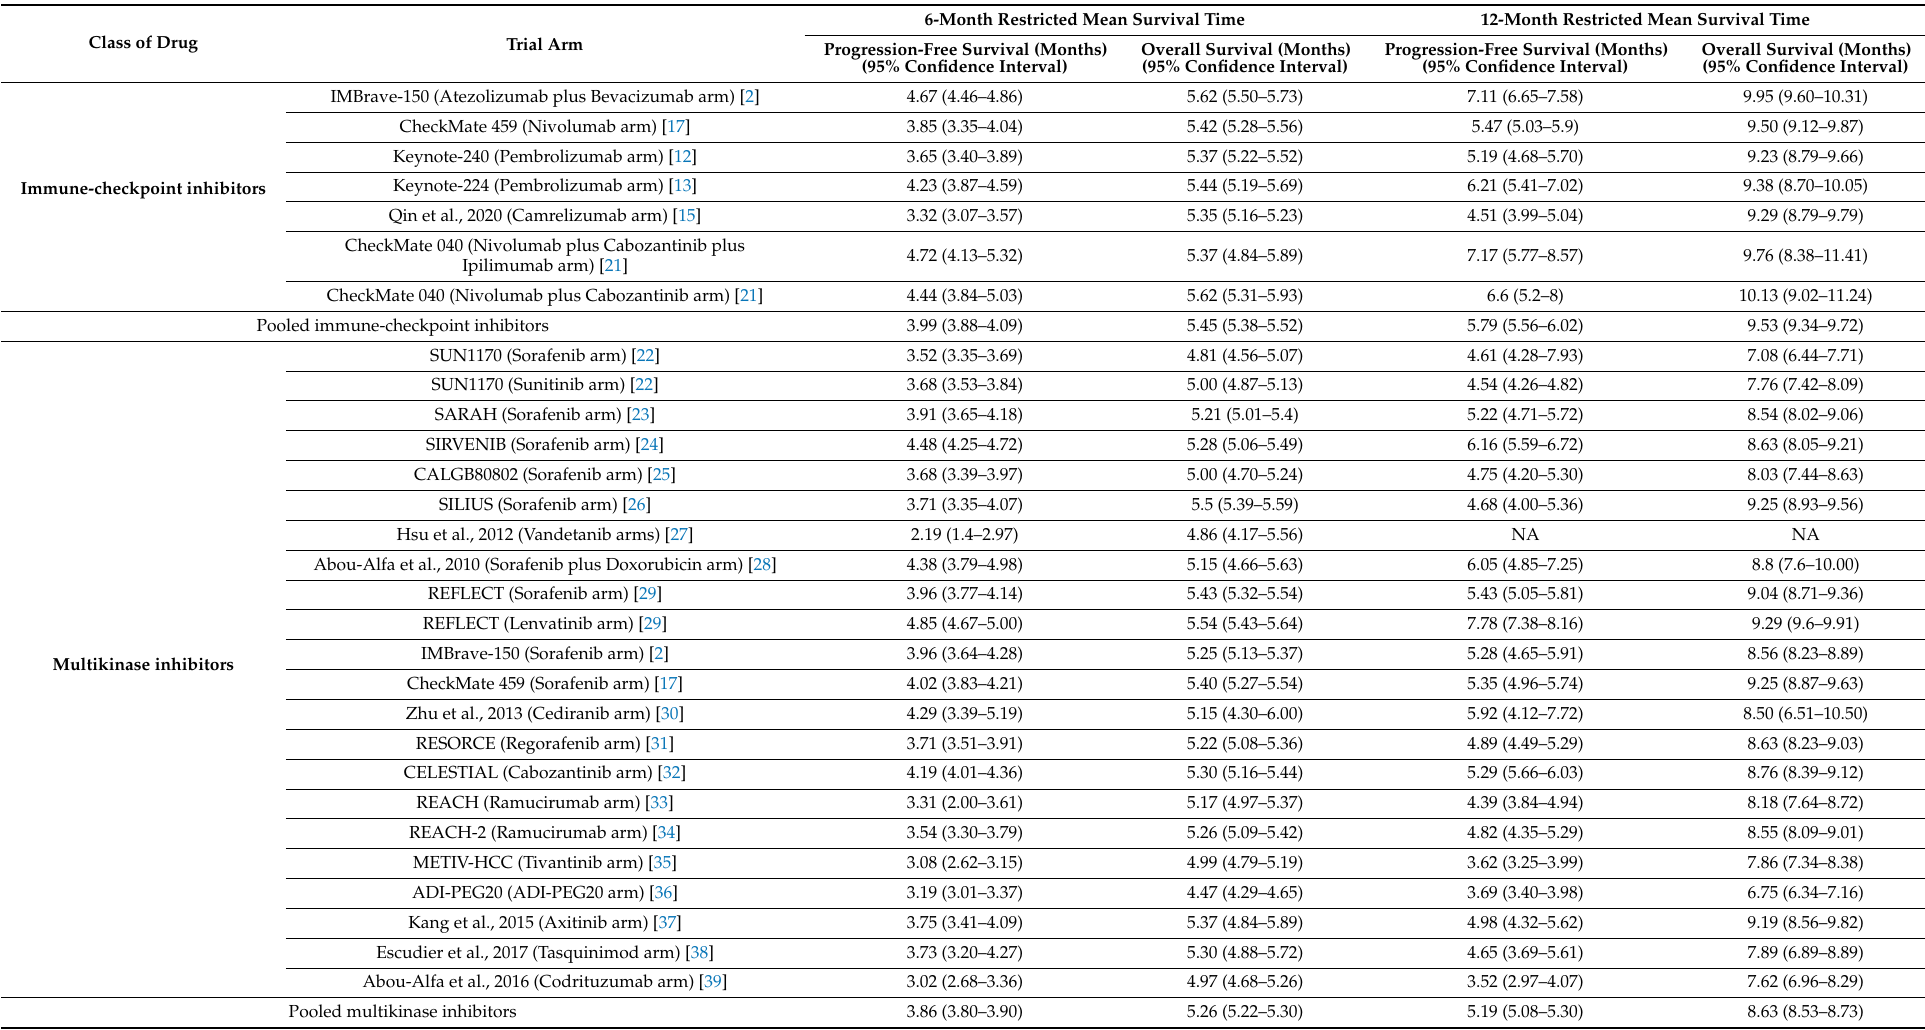
Table 2. Six-month and twelve-month restricted mean survival times (RMSTs) for progression-free survival (PFS) and overall survival (OS) in clinical trials of advanced HCC. Class of